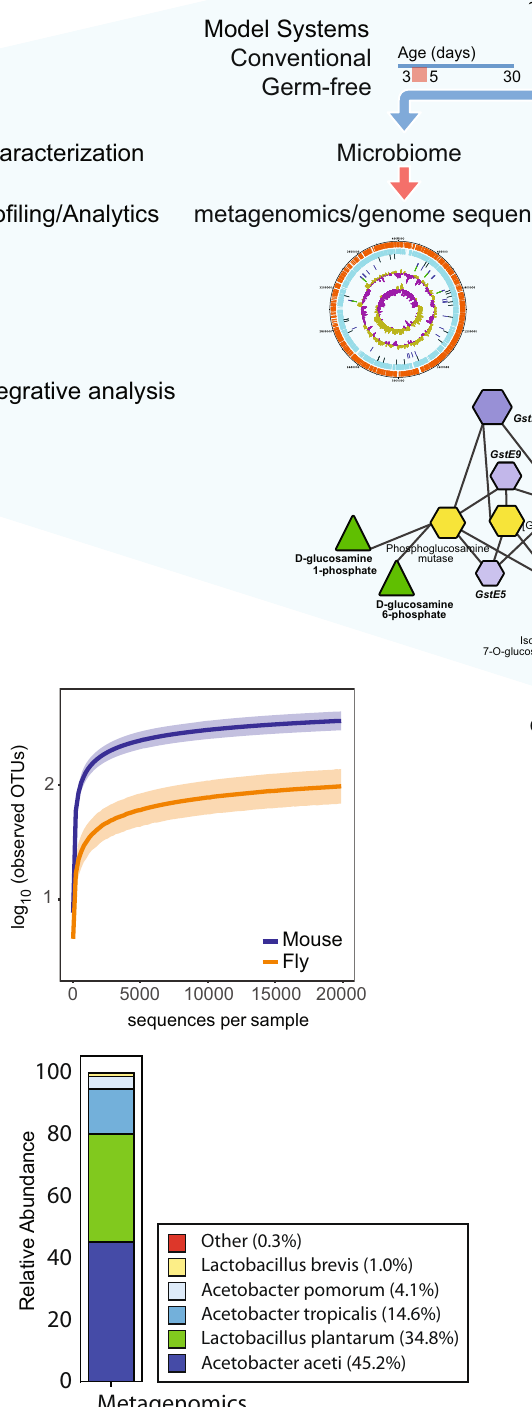
RNA sequencing analysis of conventionally and germ-free reared fl ies before and after atrazine exposure. We fi rst studied the differences in gene expression between unexposed CR and GF fl ies. We found 38 genes in males and 23 genes in females (Supplementary Fig. 1 and Supplementary Data 3 and 4) showing differential gene expression FC ≥ 3, p ≤